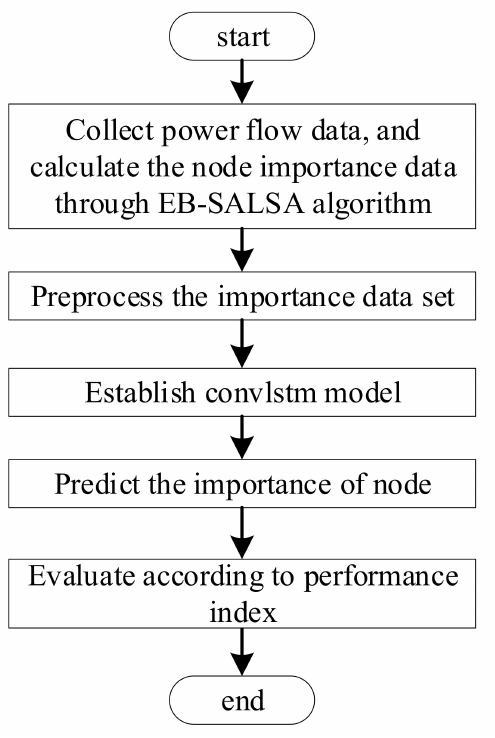
Figure 5. Complete forecasting process.